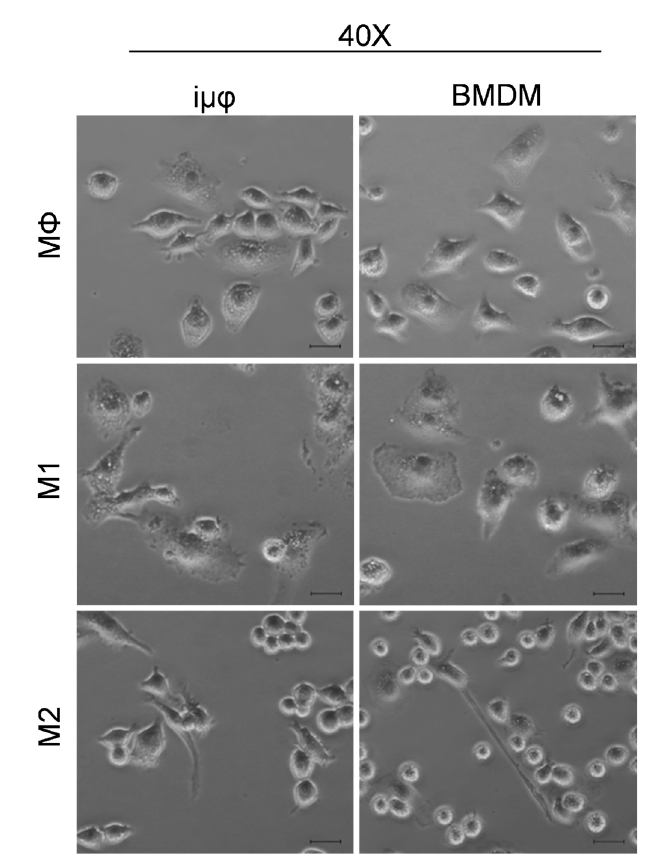
Figure A2. Transmission microscopy images of resting (MΦ), M1 and M2 stimulated iµΦ or BMDM macrophages. Scale bar, 10 µm.